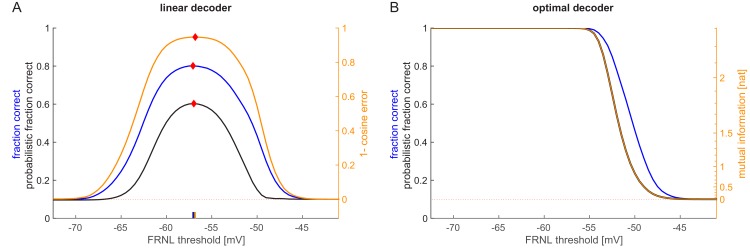
Alternative measures for the characterisation of decoding performance.(A) Linear decoding performance as a function of the FRNL threshold for fraction correct (blue), probabilistic faction correct (black), and cosine error (yellow). For fraction correct, in any given trial the class with the maximal class probability is chosen and the fraction of correct choices across trial is plotted. For the probabilistic fraction correct, class probabilities are normalised and the mean normalised class probability of the correct choice is calculated. The cosine error measure (yellow) is based on a weighted sum of the orientations characterising the classes and the cosine of the angular deviation of the resulting orientation from the true orientation is measured. While the performance of the performance measures is not equal, the optimal threshold (diamonds and ticks on the horizontal axis) is only marginally affected by the choice of measure. (B) Optimal decoding performance as measured by fraction correct (blue) and probabilistic fraction correct (black), similar to panel A. Mutual information between the population responses and the stimulus orientation (yellow) is a shifted and exponentiated version of the probabilistic fraction correct (see text). At low threshold levels, the mutual information equals the logarithm of the number of decoded orientations.